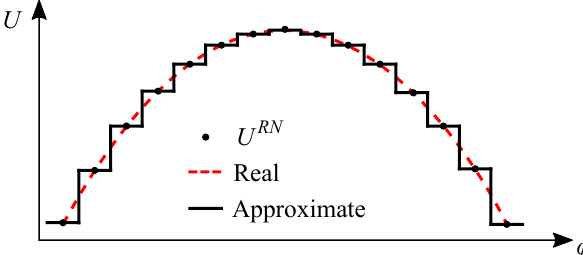
Figure 6. Approximate function of magnetic potential on the